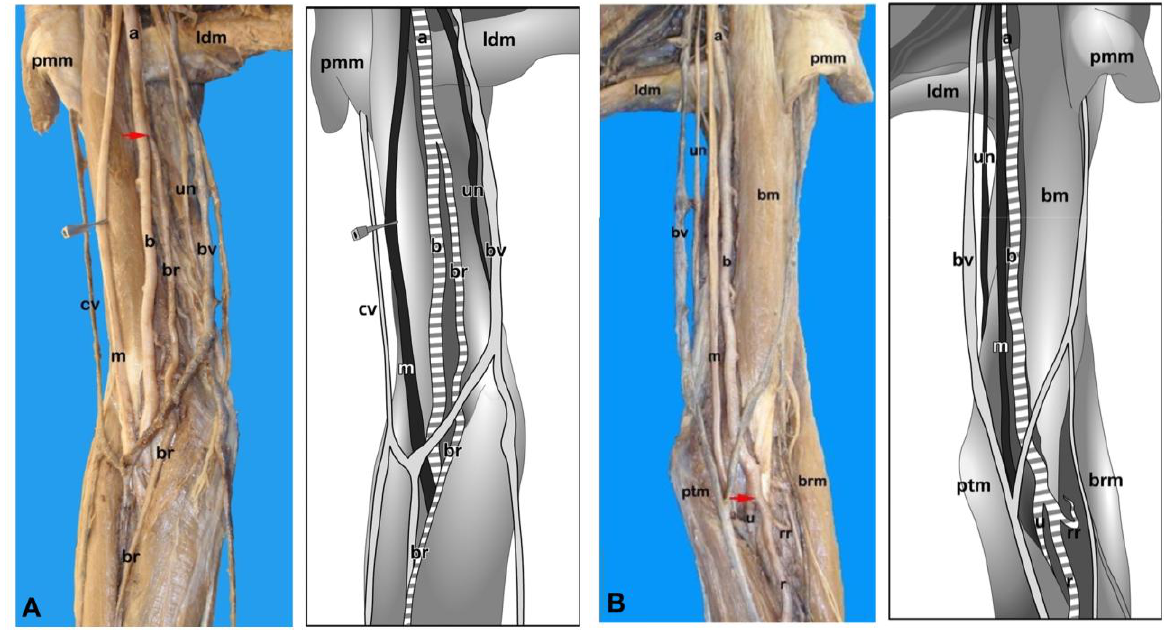
FIGURE 1. Anterior view of the arm and forearm of the male cadaver. A brachioradial (br) artery is seen to arise from the brachial artery (b) in the right arm (A). No anomalies are present in the left arm (B). The red arrow indicates the site of origin of the brachioradial artery in (A), and the origin of the radial and ulnar arteries in (B). a, axillary artery; bm, biceps brachii muscle; brm, brachioradialis muscle; bv, basilic vein; cv, cephalic vein; ldm, latissimus dorsi muscle; m, median nerve; pmm, pectoralis major muscle; ptm, pronator teres muscle; r, radial artery; rr, recurrent radial artery; u, ulnar artery; un, ulnar